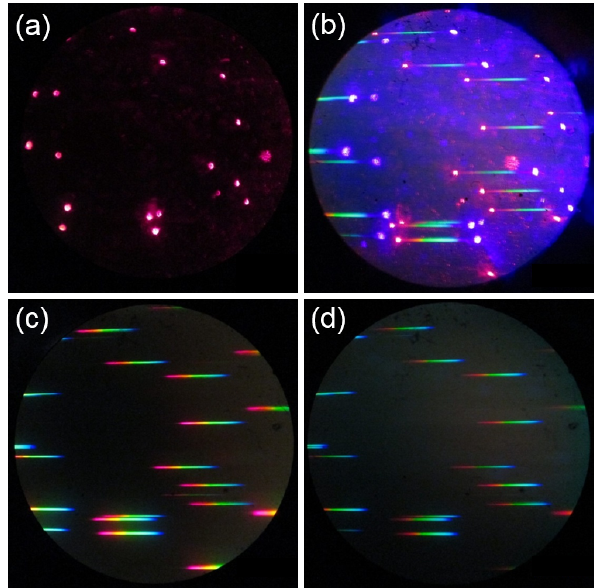
Figure 2. Four-panel progression of images acquired for a given scene of paper mulberry pollen particles collected onto a glass mi- croscope slide, analyzed using 10 × objective. Scale is the same in each figure, with each horizontal swath of color approximately 10µm in height. (a) Dark field image of particles illuminated by monochromatic red laser light ( θ = 0). (b) Particles illuminated with both violet (405nm) and red (650 nm) diode lasers. Fluores- cence spectra of individual particles showing image taken without use of blocking filter. (c) White-light illumination with tungsten fil- ament bulb. (d) Fluorescence emission with excitation from violet diode laser, but using blocking filter to remove violet laser point. Canon Powershot A2300 HD camera utilized offers 4608 × 3456 square pixels 1.3µm in